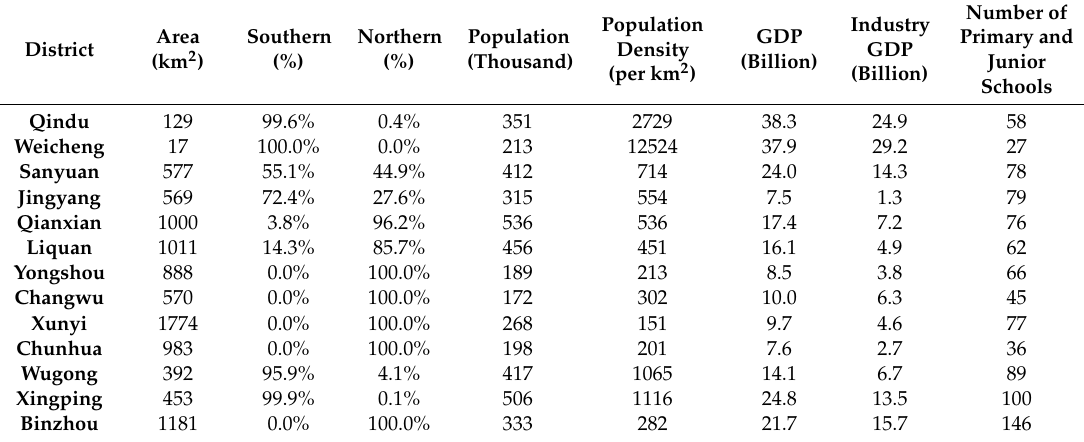
Table 1. Key social and economic indicators of administrative districts in Xianyang in 2018. Area District (km 2